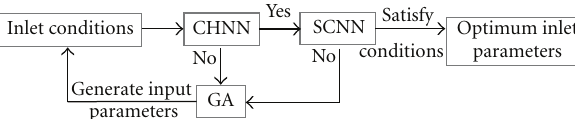
Figure 14: Second phase in modeling: optimization of inlet condi- tions to ensure combustion in the desired SOC